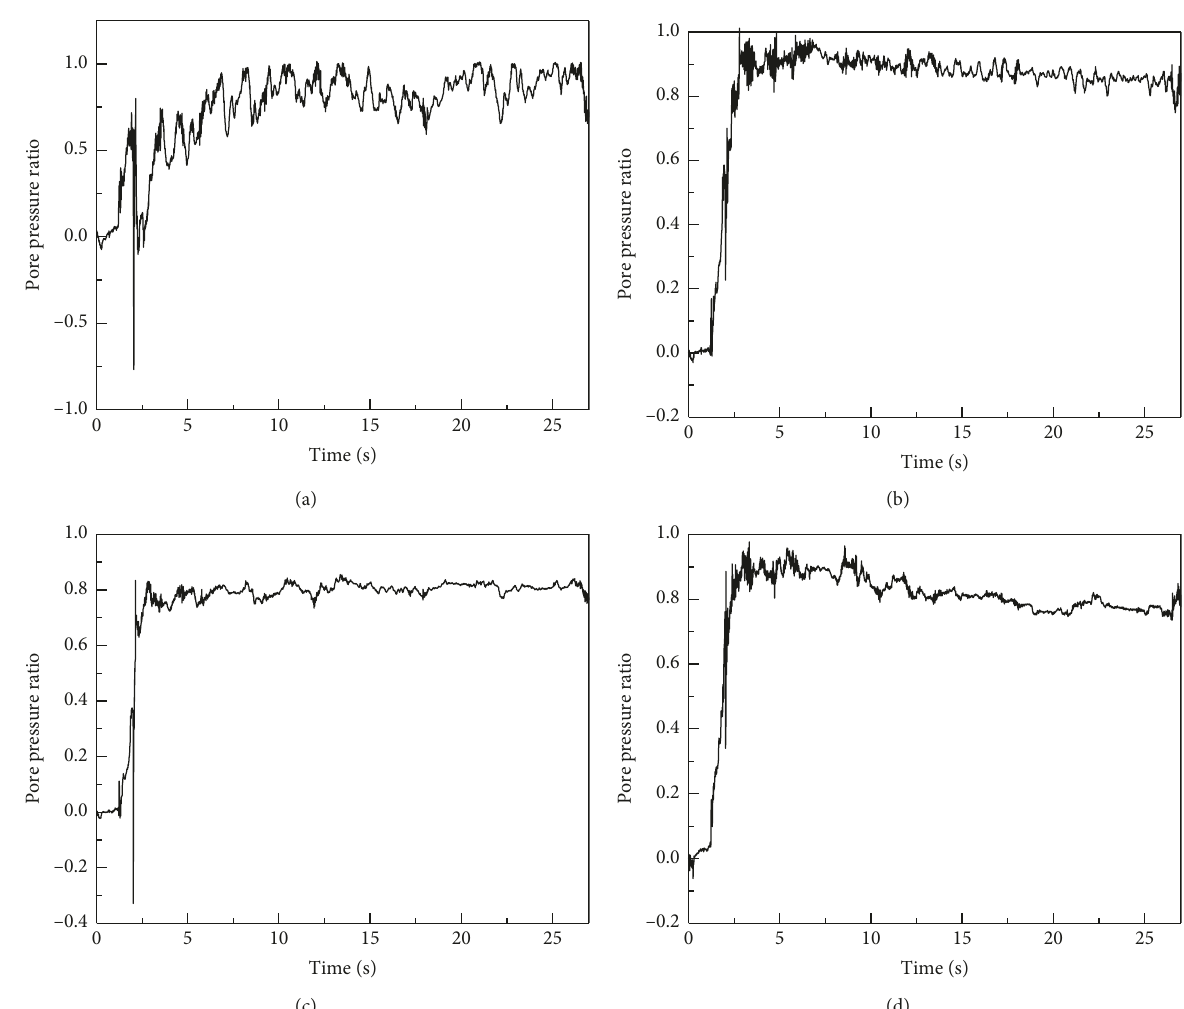
Figure 11: The time-history curves of the pore pressure ratio. (a) Pore pressure ratio at point a. (b) Pore pressure ratio at point b. (c) Pore pressure ratio at point c. (d) Pore pressure ratio at point d.